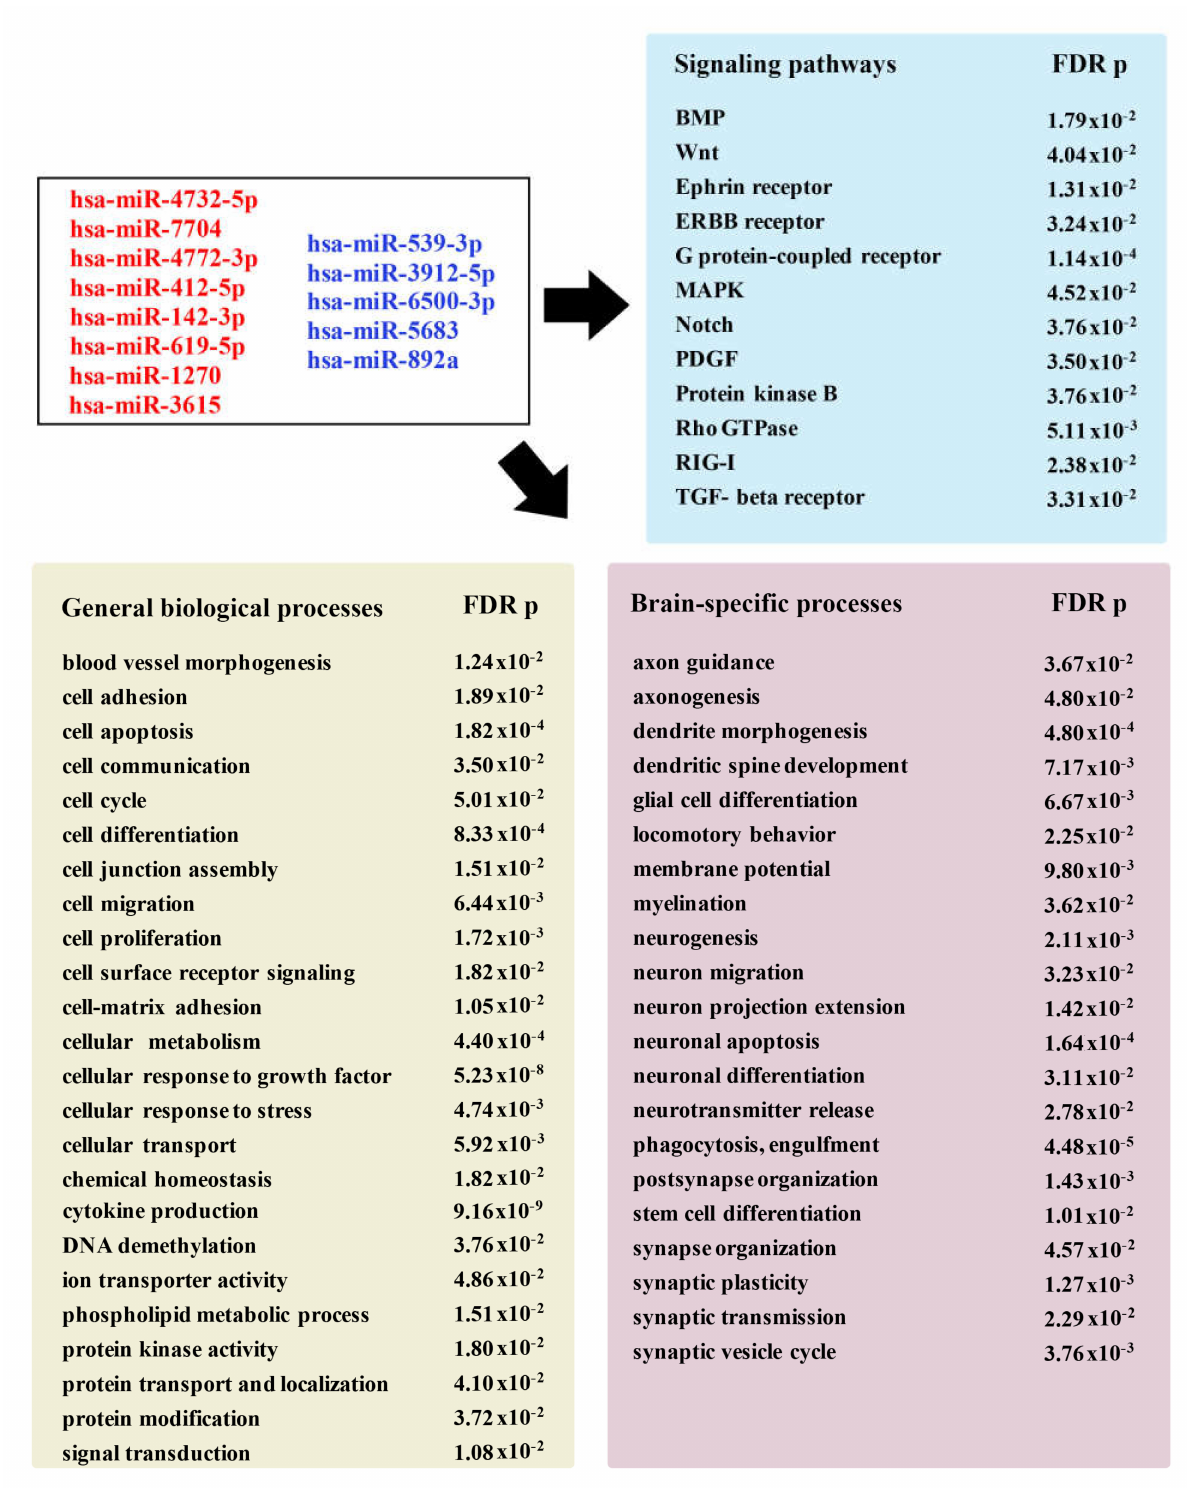
Figure 5. Pathway enrichment analysis for newly detected miRNAs. Diagram showing selected groups of GO terms (with the corresponding FDR p -value) significantly associated with the identified miRNAs (depicted in the box). The annotations describe molecular functions and signaling pathways, as well as general and brain-specific biological